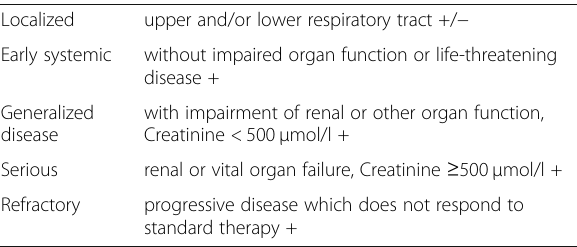
Table 2 European League Against Rheumatism (EULAR)- Definitions of AAV-Phenotypes (localized, early-systemic, generalized) and disease courses (serious, refractory) [42, 43]